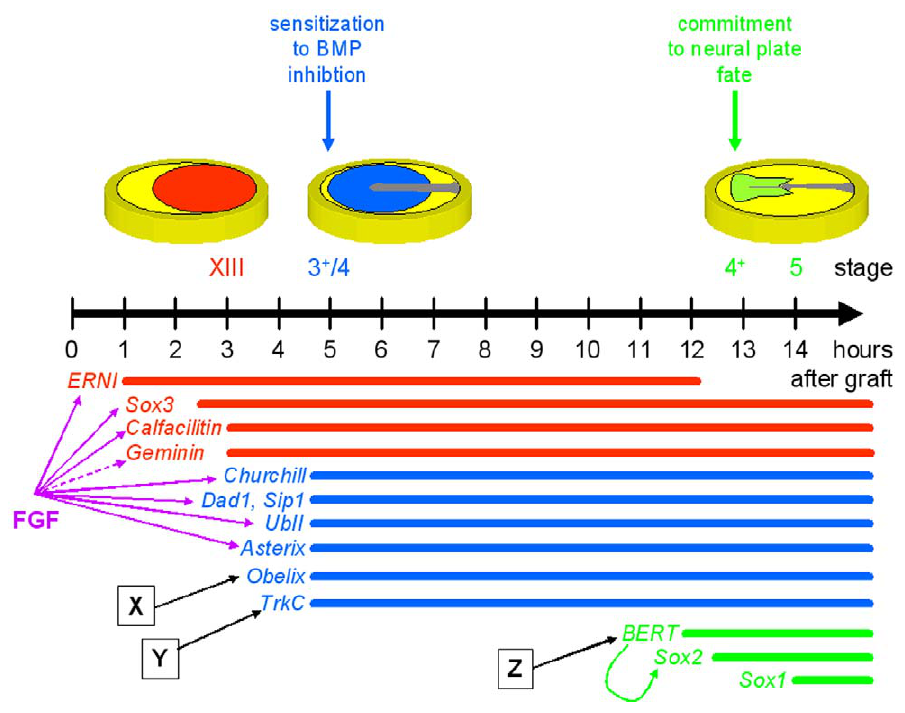
Figure 11. Time-course of markers during neural induction and their regulation by signals. Temporal hierarchy of deployment of 13 early neural markers. The colored lines at the bottom of the figure represent the period of expression of these genes, in relation to the time at which they are induced following a graft of Hensen’s node into the area opaca (in hours on the scale above) and in relation to the stage of normal embryos at which they are expressed (stage shown above the time line). The diagrams above these stages schematize the domains of expression. The genes fall into three ‘‘epochs’’: those induced by a node within 3 hours start to be expressed in normal embryos before streak formation (red). Those induced by a node in 4–5 hours begin their expression at the mid- to late-primitive streak stage (blue) and those that are induced by a node at 12–13 hours do not begin their expression until the end of gastrulation, in the forming neural plate (green).